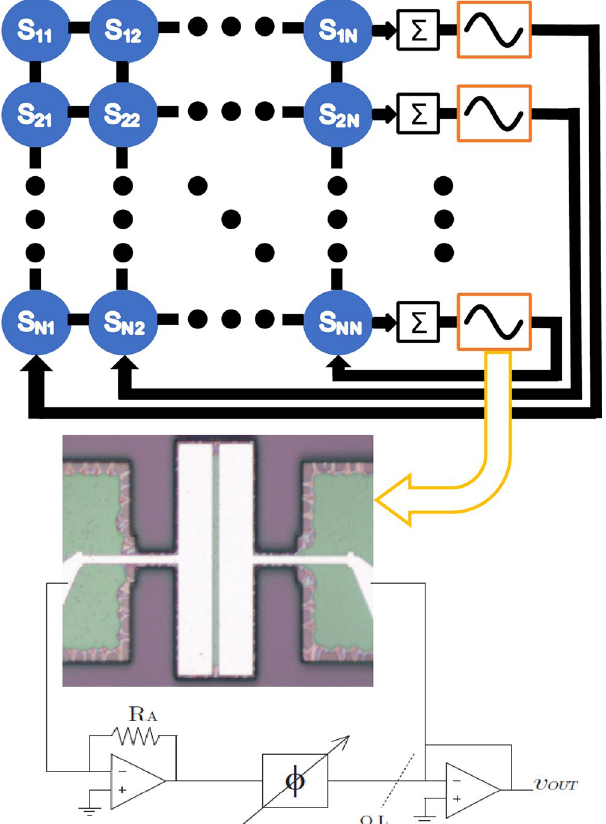
Figure 1. Schematic of oscillator network with all-to-all coupling. Signals across the array are summed with weights determined by equation (8). Each individual self-oscillator is comprised of a MEMS resonator (optical micrograph of a plate-type resonator shown below) placed within a feedback loop with a transimpedence amplifier, phase shifter, and output buffer that satisfies Barkhausen’s